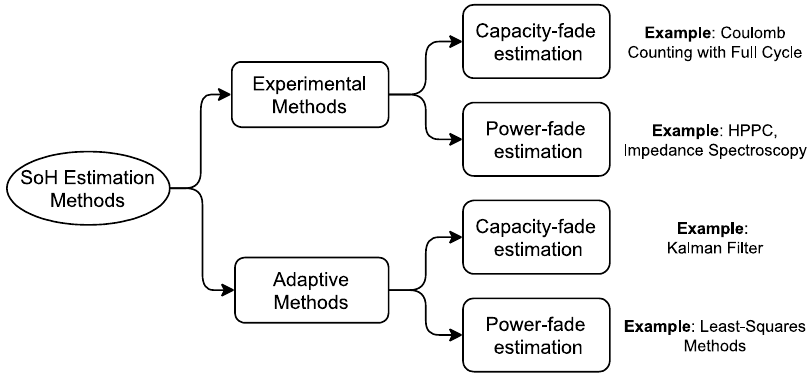
Figure 1. State ‐ of ‐ the ‐ art methods for State ‐ of ‐ Health (SoH)